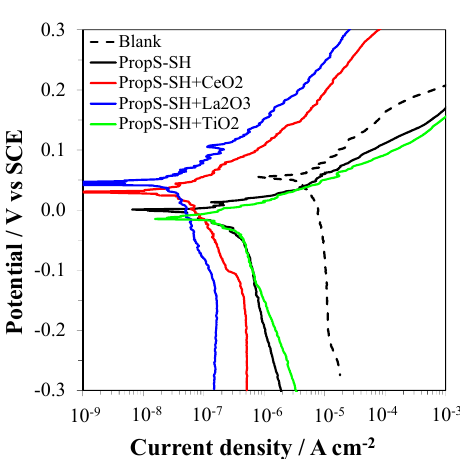
Figure 6. Polarization curves recorded after 20 days of immersion in AR × 10 at 30 °C, on bare (blank) and coated bronze. The coatings consist of plain PropS-SH and PropS-SH charged by CeO 2 , La 2 O 3 , or TiO 2 nanoparticles. Conditions of coating preparation: 30-day storage time of the silane solution at 4 °C, 7-day aging of the suspensions at 4 °C, 10-day curing at RT.